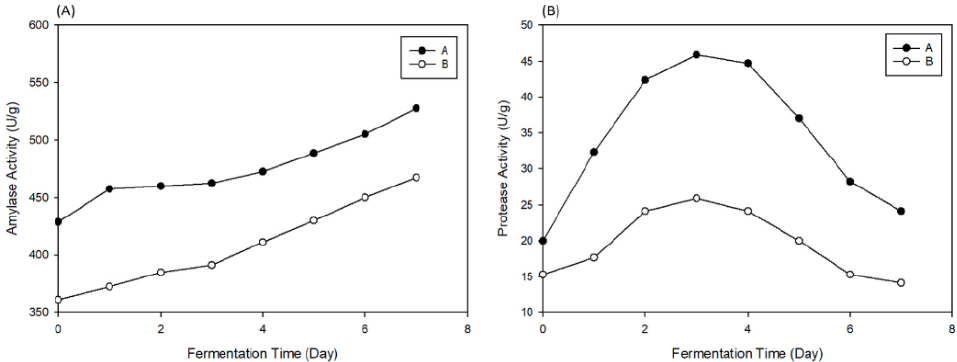
Figure 4. The changes in amylase ( A ) and protease ( B ) activities during secondary fermentation.